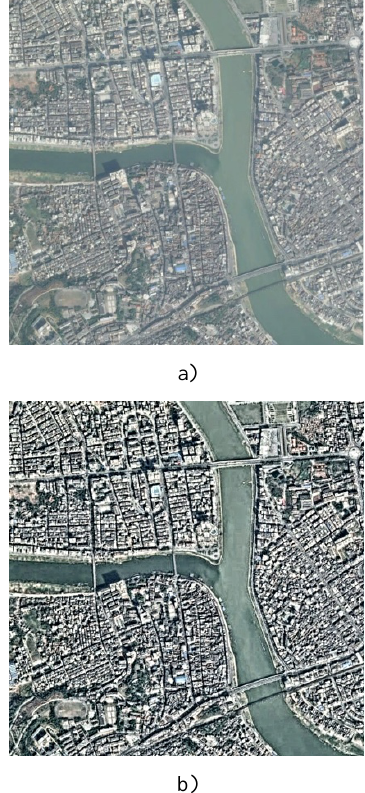
Fig. 8 . Enhancement results for the Image #5. Table 1. Comparison of resulting EMEC’S of